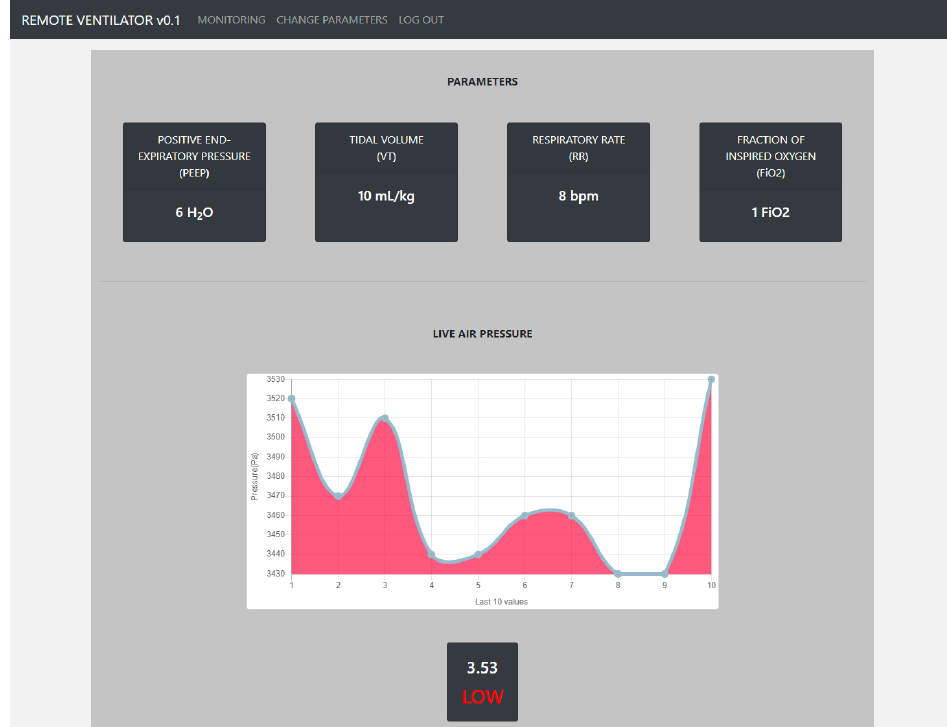
Figure 9. Remote ventilator dashboard reflecting the change in parameters over the communication network.